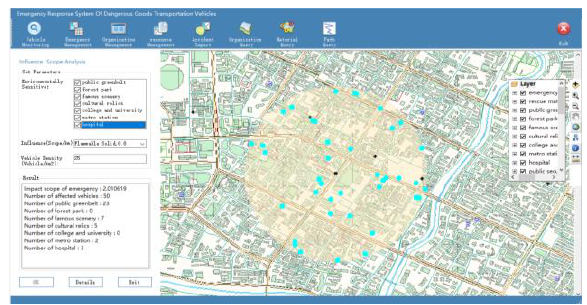
Figure 5. Disaster area analysis results.